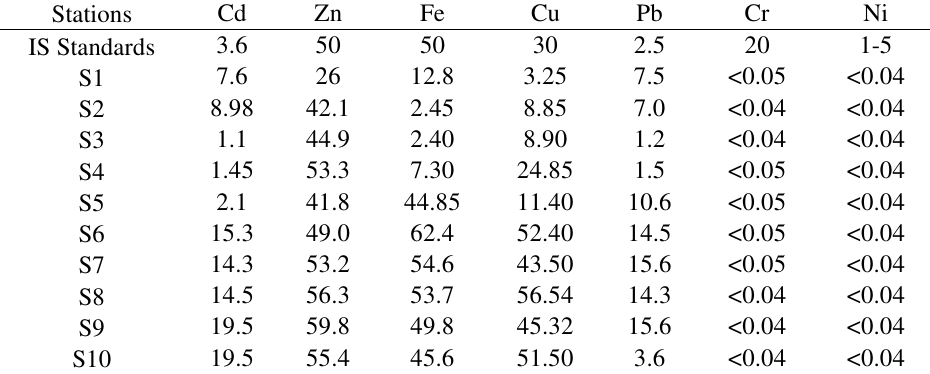
Table 3. Heavy metals (mg/kg of dry wt) in random samples of coriander collected from fields around the lakes of Bengaluru Stations IS Standards